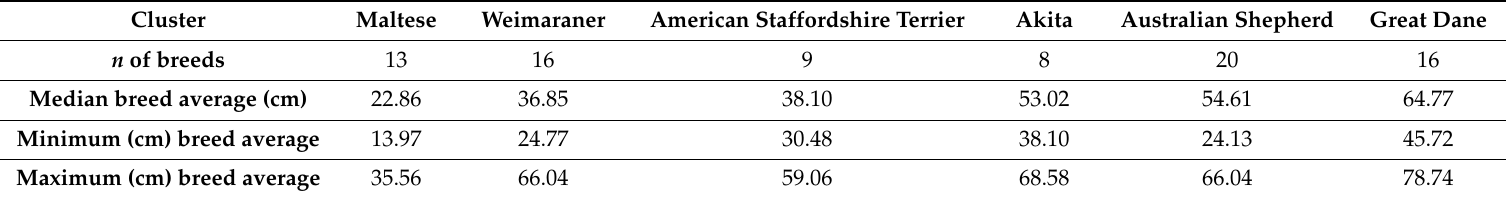
Table 3. Cluster median, minimum, and maximum heights (ordered from left to right by median cluster height). Cluster